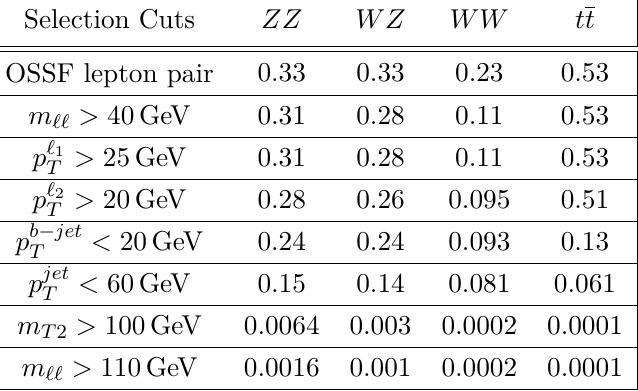
= 1 GeV following the analysis ˜ χ 0 1